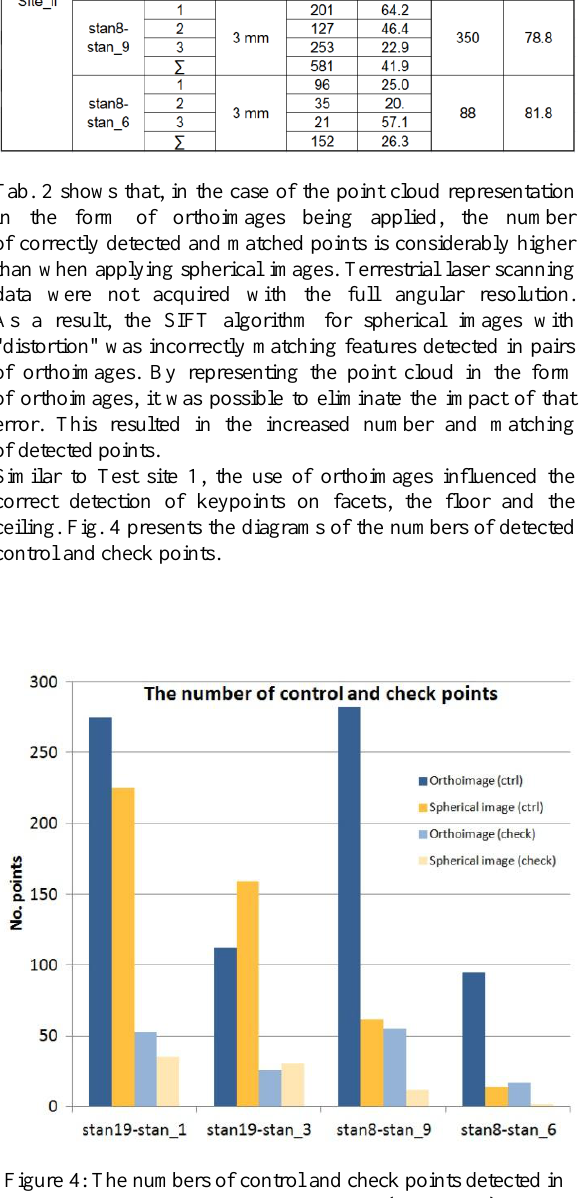
Figure 3: The numbers of control and check points detected in spherical images and orthoimages (Test site I)